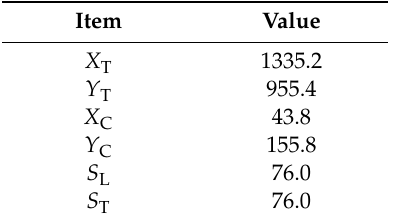
Table 4. Predicted ply thickness.